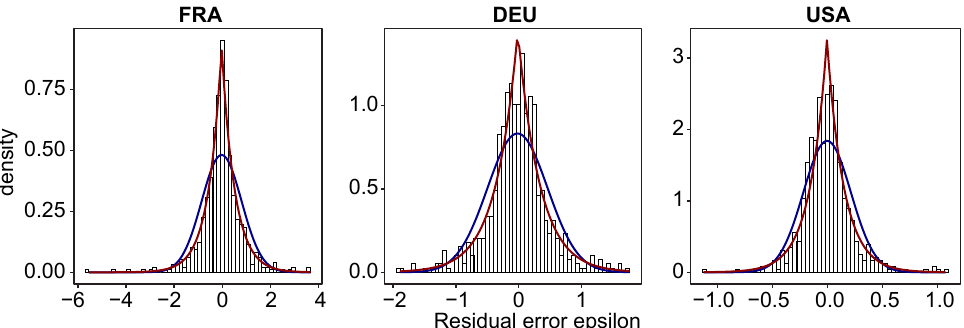
Figure 7. For France, Germany and USA, histogram of the normalized error ε t , using the festive day correction, its normal approximation (blue line) and its optimal approximation using an exponential distribution (red line) (we use the R-package normalp to approximate ε t by an exponential distribution). See Figure A4 for the results for the same countries and 33 more countries without using the festive day correction.